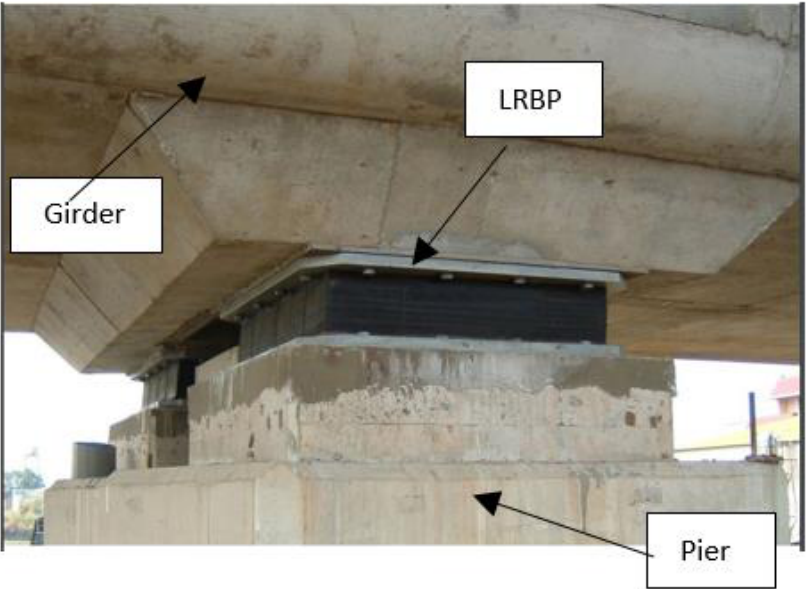
Figure 1. Laminated rubber bearing Pad (LRBP) reproduced from [31]. In the VD-LRBP system, viscous dampers are placed in conjunction with LRBPs in the direction of the earthquakes (Figure 2). Their role is to dissipate earthquake energy and control the large relative displacement between girders and piers caused by sliding at bearing, and to prevent expansion joint failure or span collapse.